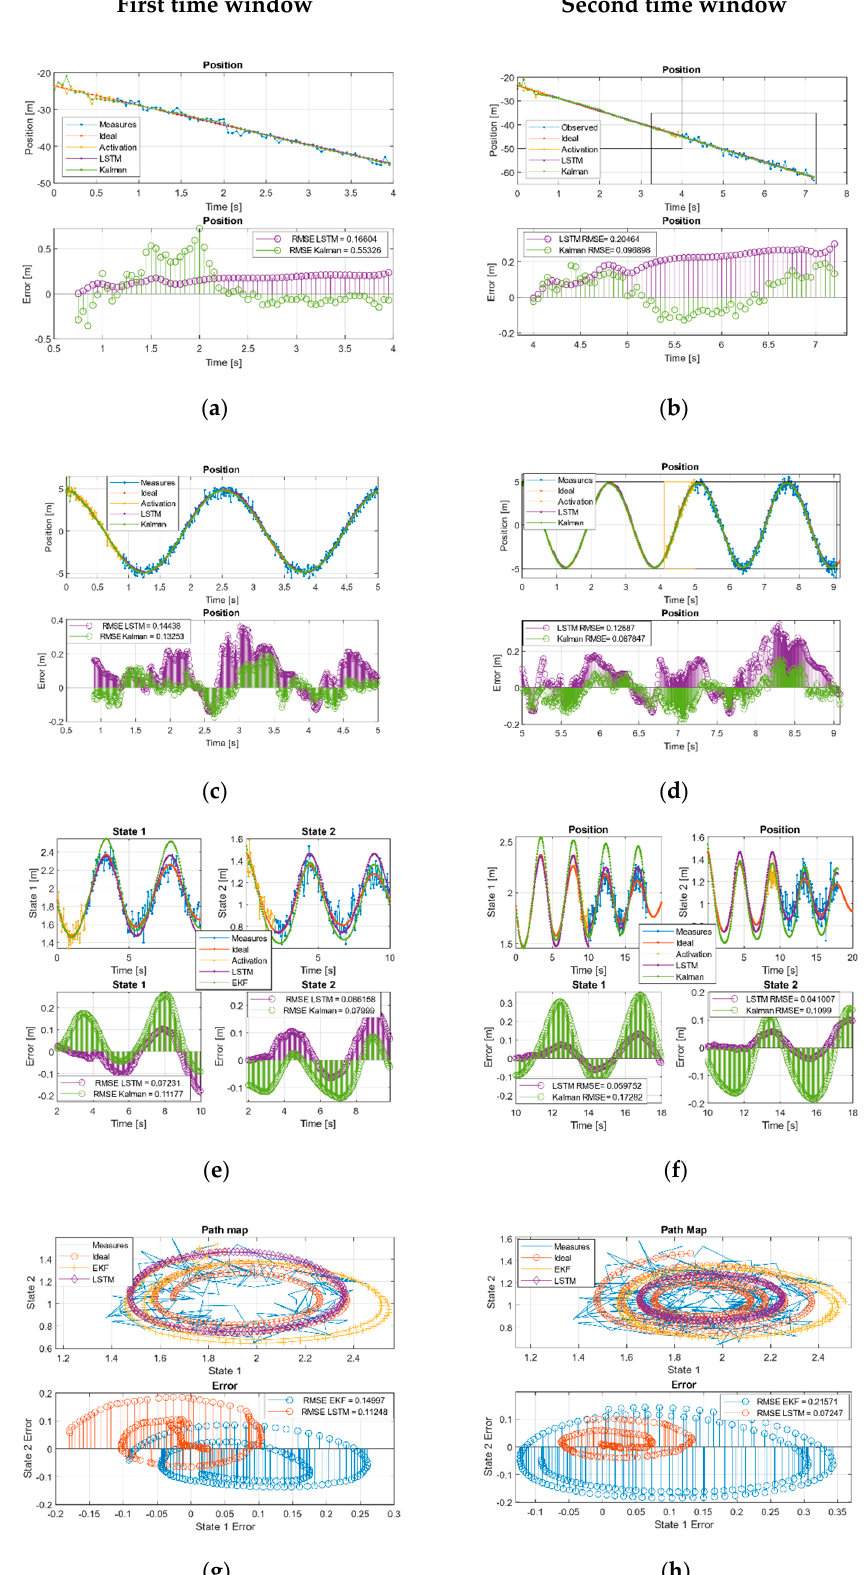
Figure 3. Kalman and LSTM with new feed measurements. ( a ) First and ( b ) second time window URM path evolution. ( c ) First and ( d ) second time window sinusoidal path evolution. ( e ) First and ( f ) second, time window Volterra path evolution in both two states. ( g ) First and ( h ) second window, Volterra phase diagram evolution.